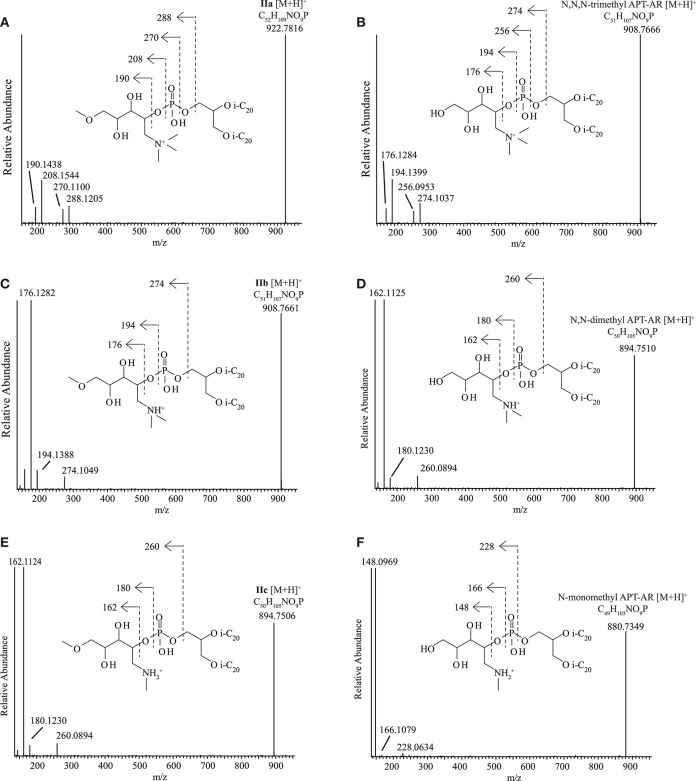
UHPLC-HRMS MS2 spectra with structures and fragmentations indicated for (A)
N,N,N-trimethyl aminomethoxypentanetriol (trimethyl APT-Me, IIa), (B)
N,N,N-trimethyl aminopentanetetrol (trimethyl APT), (C)
N,N-dimethyl aminomethoxypentanetriol (dimethyl APT-Me, IIb), (D)
N,N-dimethyl aminopentanetetrol (dimethyl APT), (E) N-monomethyl aminomethoxypentanetriol (monomethyl APT-Me, IIc), (F) N-monomethyl aminopentanetetrol (monomethyl APT). i-C20, C20 isoprenoid chain.